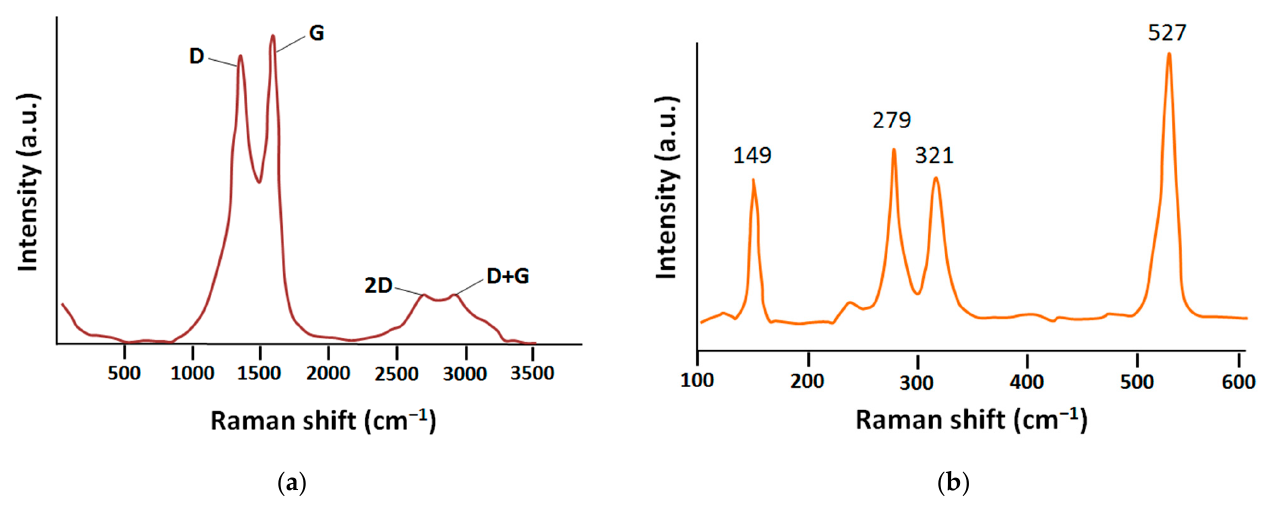
Figure 1. Raman spectra of samples: ( a ) GO; ( b ) ZrS 3 .